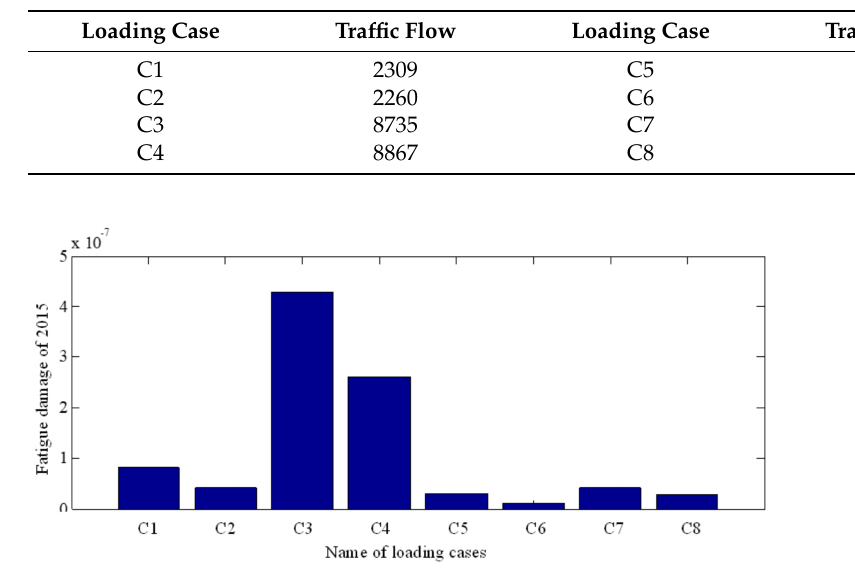
Table 5. Traffic flow of eight loading cases.